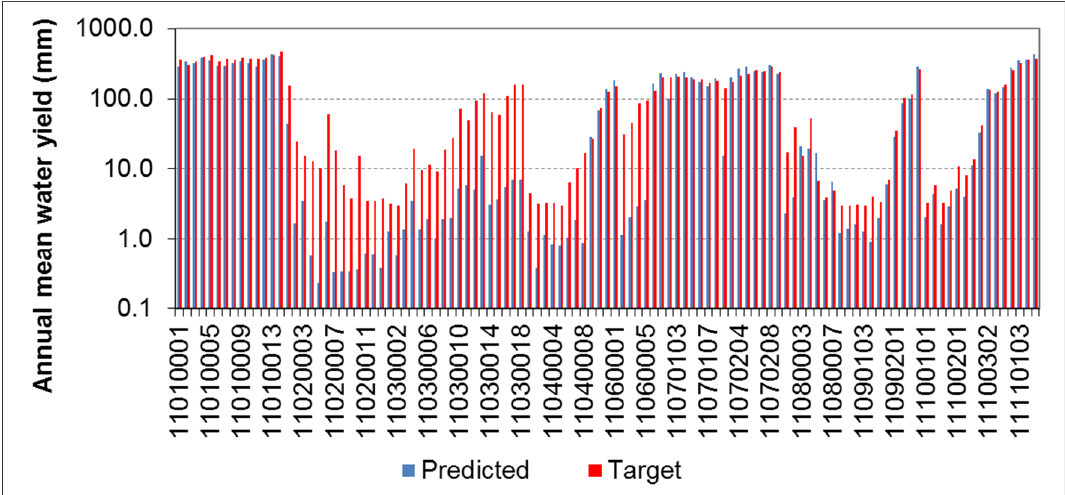
Figure 5. Annual water yield for Arkansas-White-Red river basin.